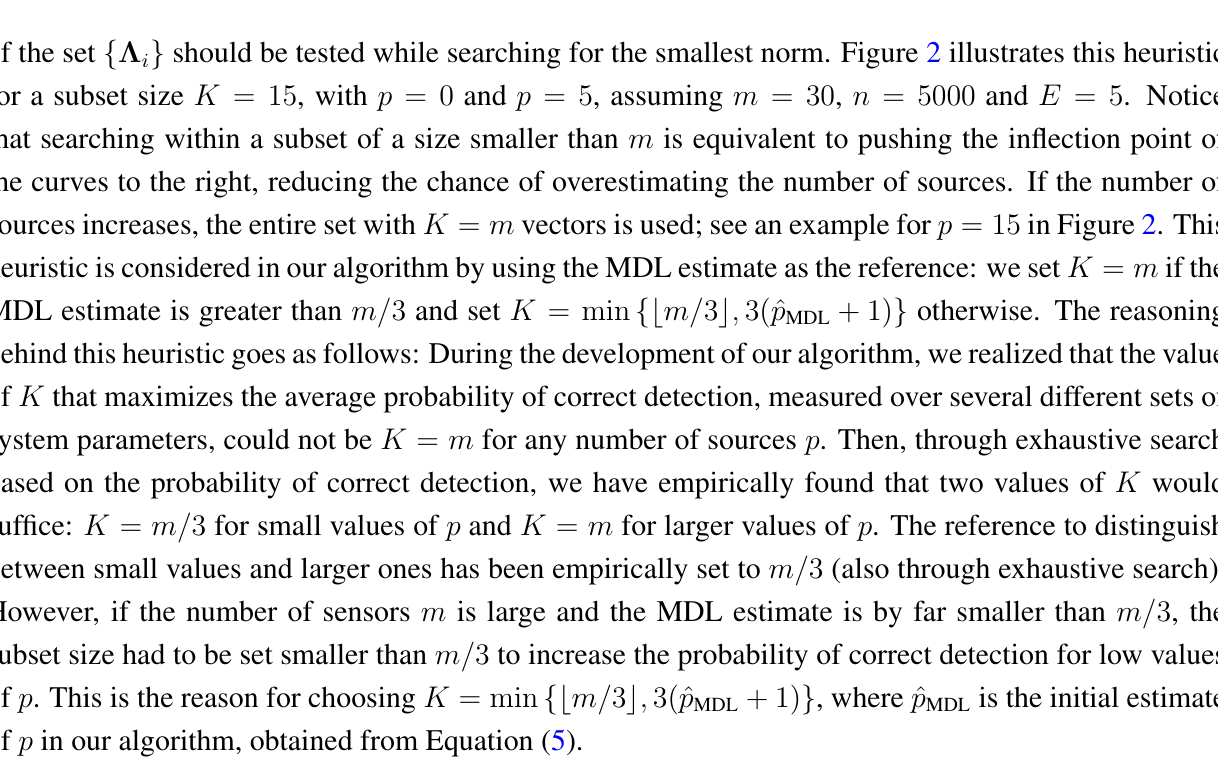
Figure 2. Normalized eigenvalues and indexes according to the iMDL